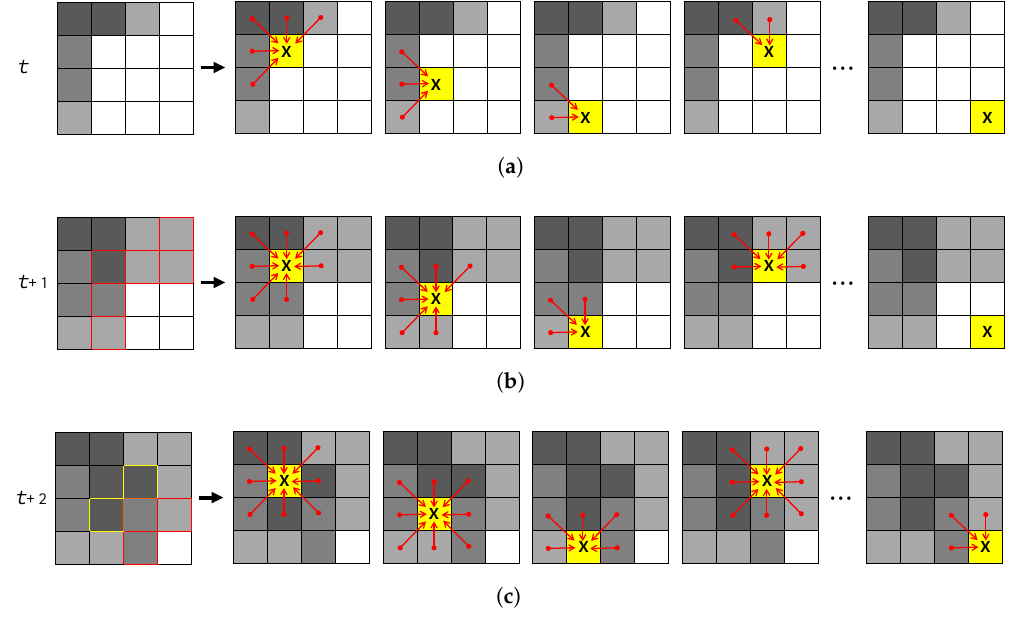
Figure 8. Cell evolution steps by SCA. ( a ) is at time t ; ( b ) is at time t + 1; and ( c ) is at time t + 2. The first column shows the initial cell state at the time. (The area in yellow marked X indicates the current defender and the red arrow is the direction of attack on the defender by its neighboring cell, represented as the attacker. The rectangular areas in red and yellow indicate that the cell state has